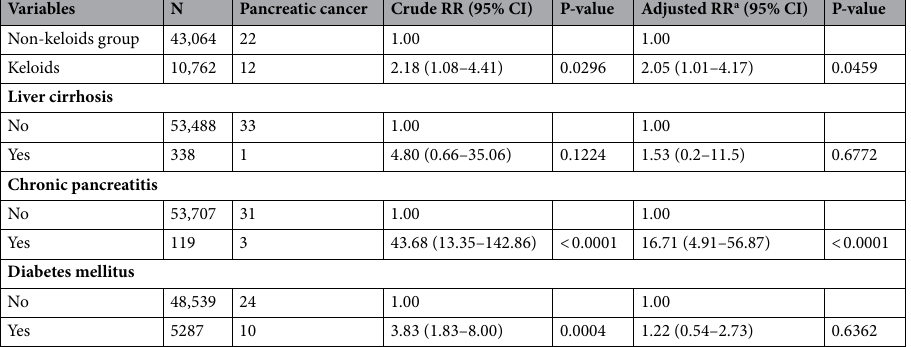
Table 5. Pancreatic cancer risk in female patients with keloids, stratified by comorbidities. RR relative risk, 95% CI 95%confidence interval. a Model adjusted for age group, gender, the residential region and related comorbidities using a Cox proportional-hazards regression